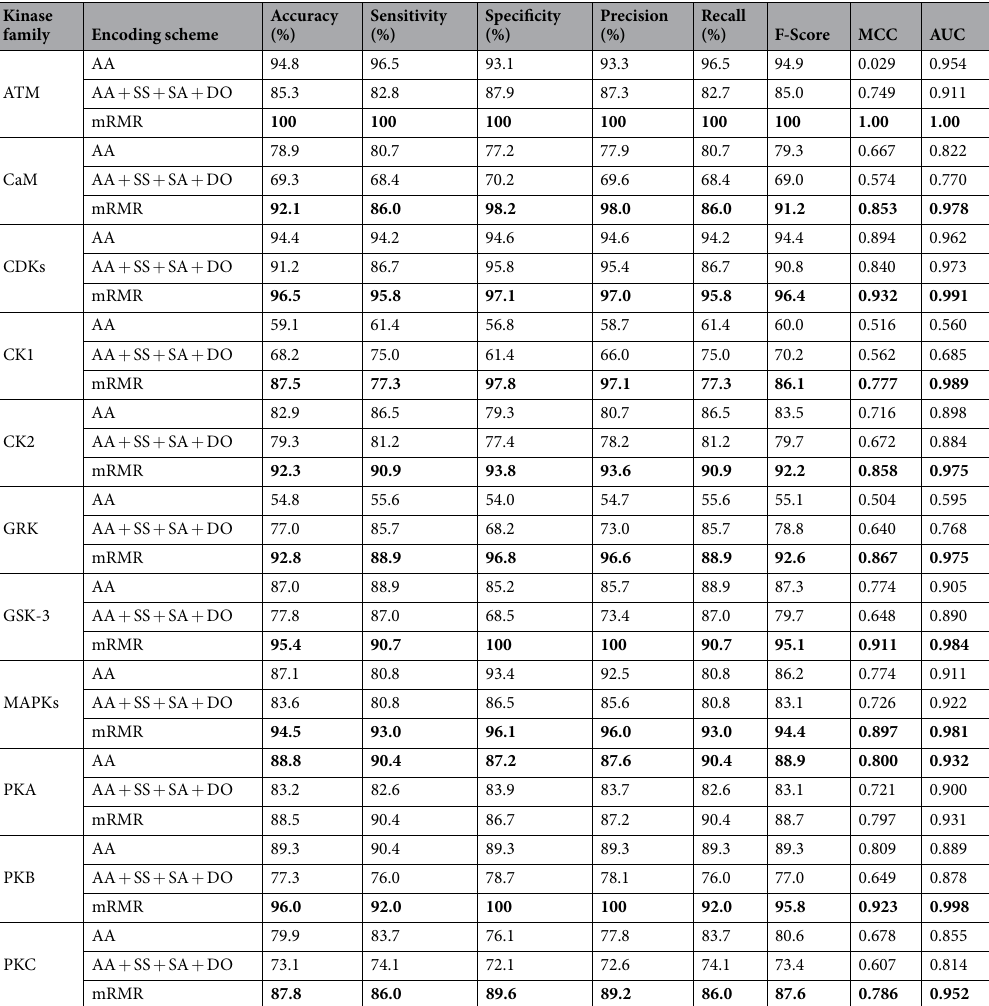
Table 3. Performance comparison with different sequence encoding schemes based on the 5-fold cross- validation tests. The best results for each kinase and performance measure are highlighted by bold. AA: binary encoding of amino acid sequence; SS: secondary structure; SA: solvent accessibility; DO: disorder; MRMR: sequence encoding scheme after mRMR feature selection based on all